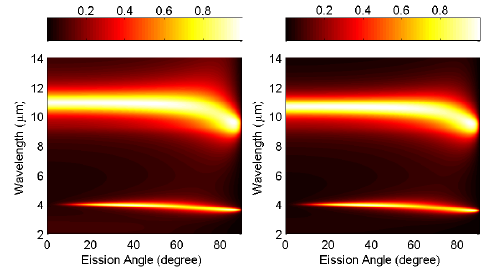
Figure 4: Emissivity of the bilayer in Fig. 1 vs. emission angle ( θ ) and wavelength. The permittivity of the primary layer is described by Drude-Lorentz model given by Eq. (3). The secondary layer is copper (left) and PEC (right). The thickness of the DL and Cu layers is, respectively, 0 . 35 µ m and 0 . 15 µ m. Color bars represent the magnitude of the emissivity. The shorter (longer) wavelength band is located at the left (right) side of the Lorentzian resonance (see left panels in Fig. 2).